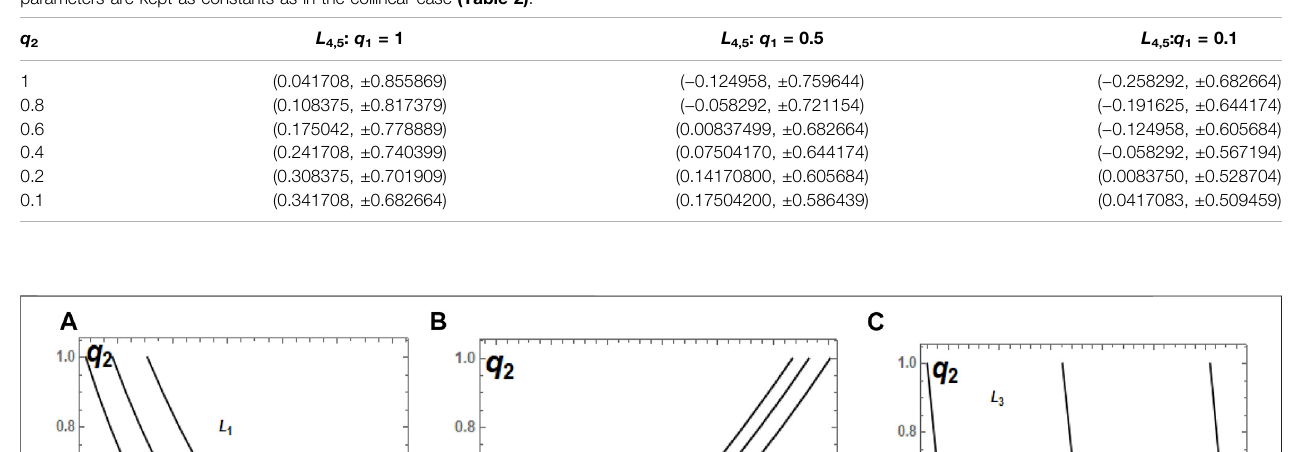
TABLE 3 | Positions ( x 0 , ± y 0 ) of the triangular points of the binary HD155876 system for three fi xed values of q 1 when q 2 radiates. The disc, oblateness, and triaxiality parameters are kept as constants as in the collinear case (Table 2)